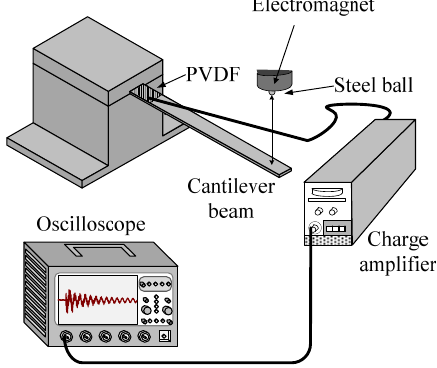
Figure 1. Illustration of the experimental setup.